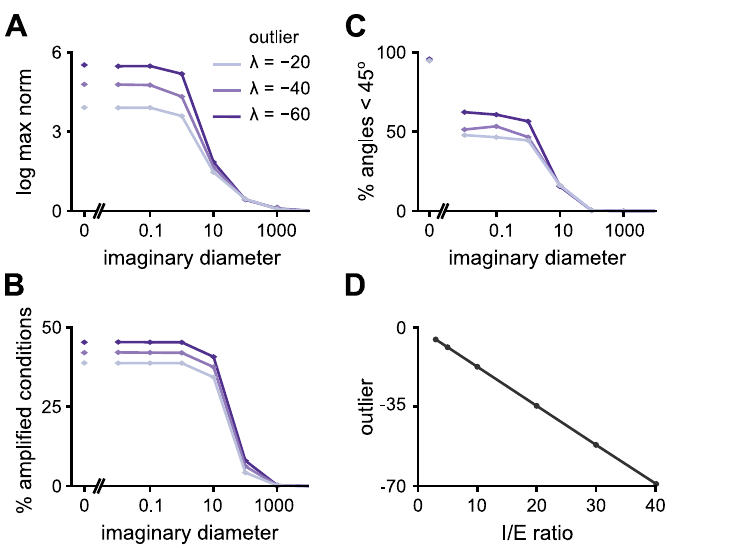
Fig 6. A large negative outlier increases amplification in upper triangular matrices without self loops and is proportional to I / E ratio in networks satisfying Dale’s law. A , Maximum response norm for the preferred initial condition as a function of the imaginary diameter using upper triangular connectivity matrices with the zero trace condition and different outliers (coloured coded). The network size is N = 200 and the feedforward Frobenius norm is set to 75 in all cases. B , Percentage of directions whose norm is amplified more than 50% as function of the imaginary diameter as in panel A. C , The percentage of angles, between pairs of eigenvectors, that are less than 45˚, as a function of the imaginary diameter as in panel A. D , Position of the outlier as a function of the I / E ratio for a network with 100 excitatory and 100 inhibitory neurons sparsely connected with no self loops. An initially random network is optimised with the Stability-Optimised Circuit (SOC) algorithm [8] with I / E = 40 (see Methods). The additional outliers are calculated by linearly scaling all inhibitory weights to I / E = 3, 5, 10, 20,